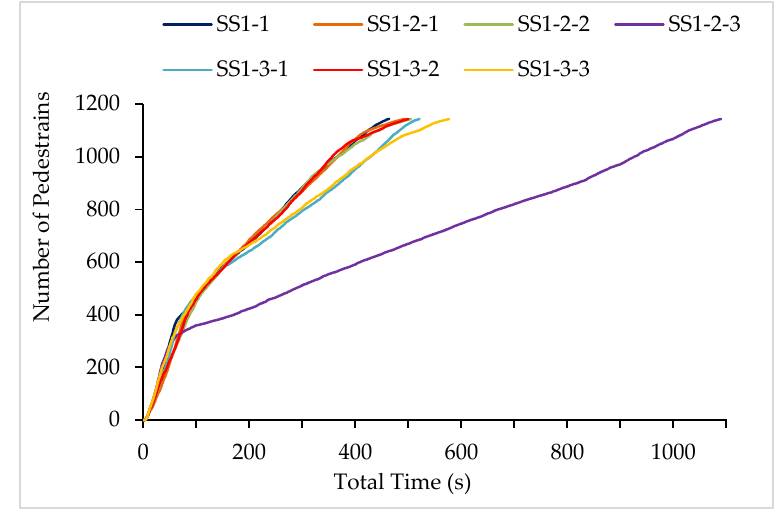
Figure 4. The number of occupants exiting from the main building under 7 sub-SSs.